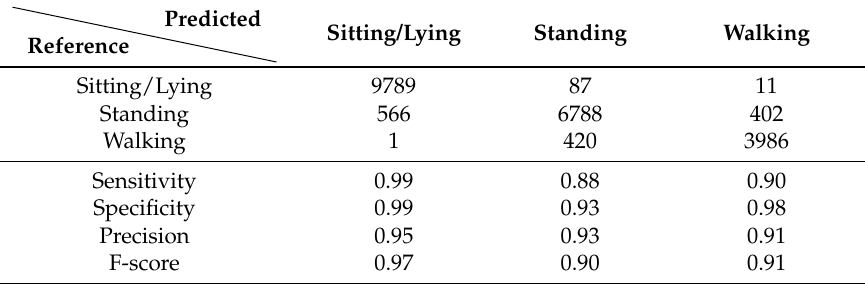
Table 2. Confusion matrix and classifier performance compared to reference activity. Each unit represents a 6 s activity epoch.